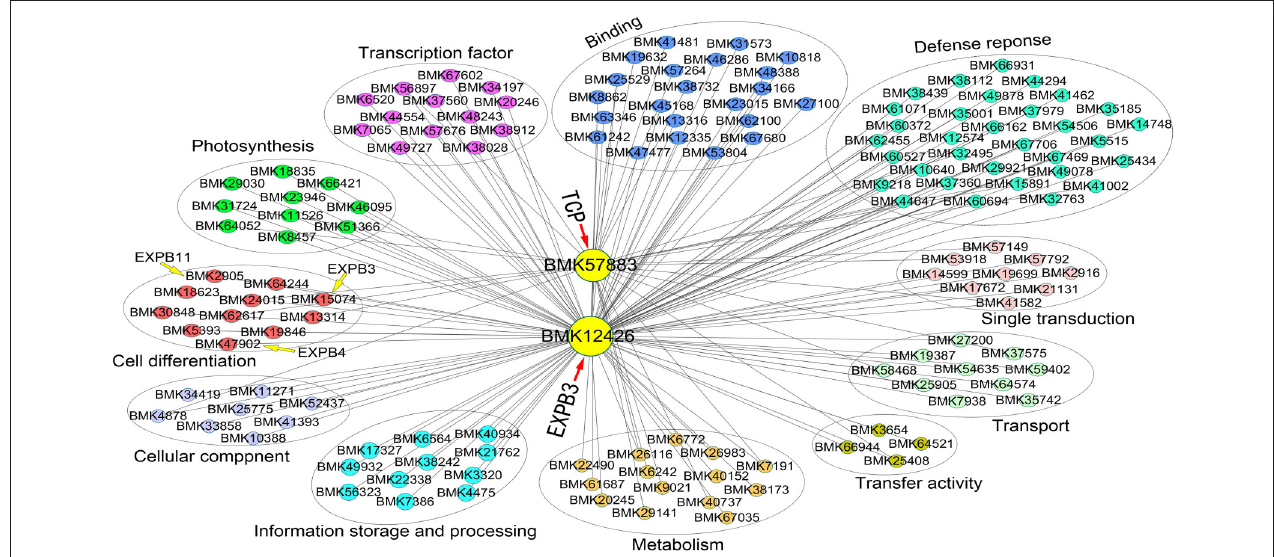
FIGURE 8 | Coexpression network of EXPB3 and TCP based on the DGE data of different ploidy plants of Dendrocalamus latiflorus.